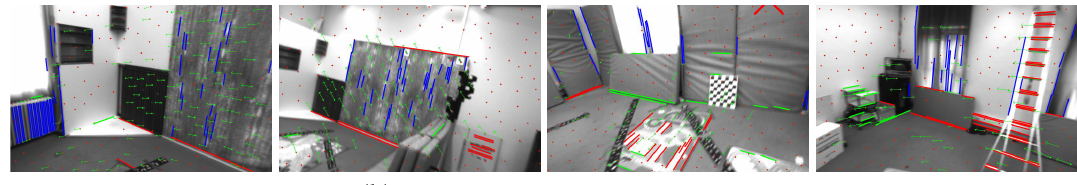
Figure 5. The performance of structural features in MH_03_medium and V1_02_medium sequences of the EuRoC dataset. The structural features encode the global rotation information and effectively restricts the accumulated rotation error, thus reducing the translation error.